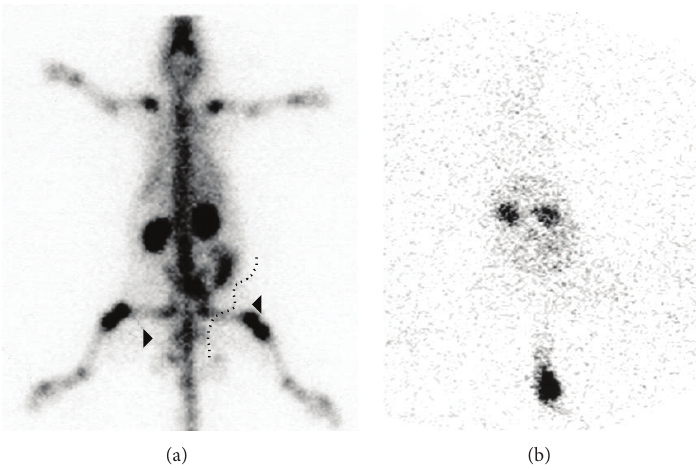
Figure 2: Four-hour whole body images of rats with a TNBS-colitis, injected with (a) 99 m Tc-alafosfalin (annotated line represents the descending colon plus increased uptake 󳶣 in distal colon) and (b) 99 m